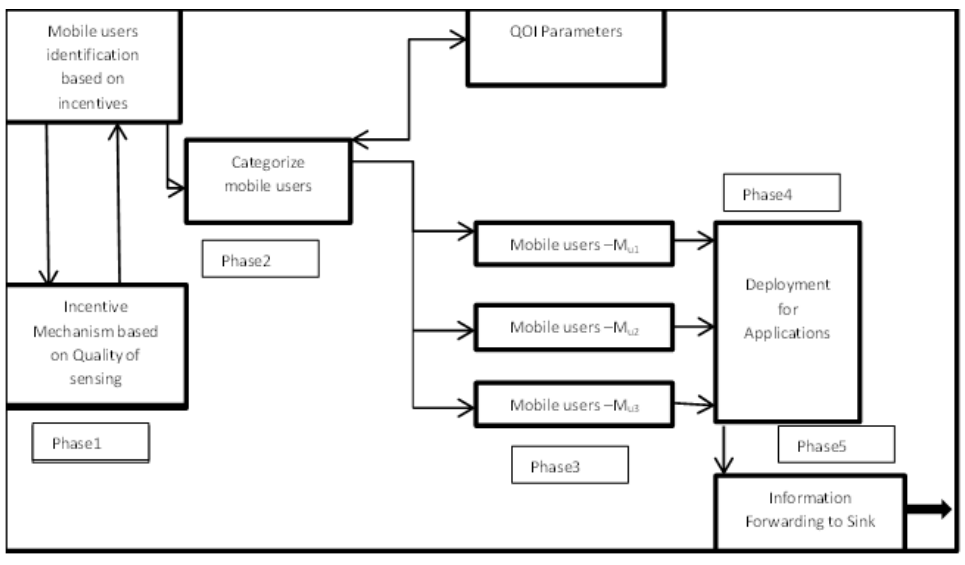
Figure 1. QACM system architecture.